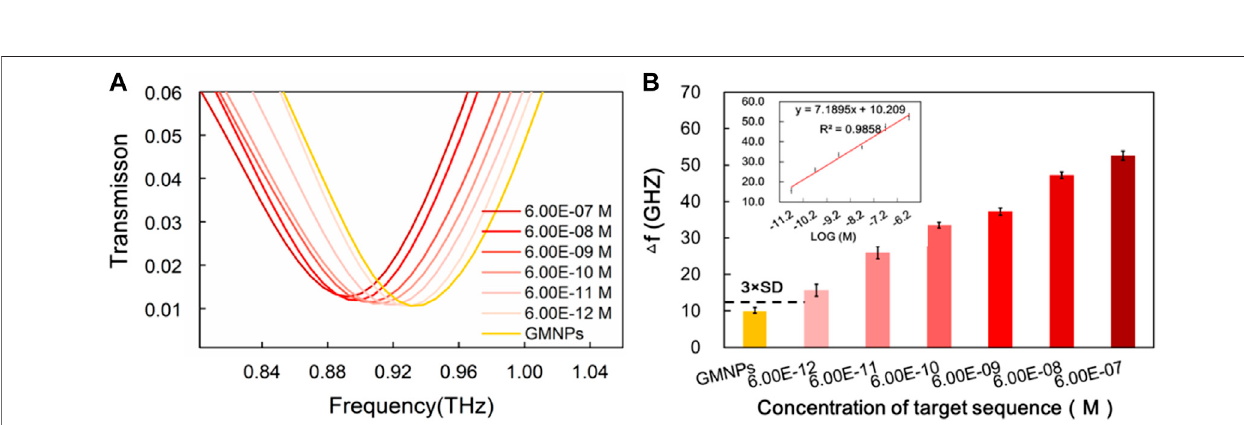
Frontiers in Bioengineering and Biotechnology |